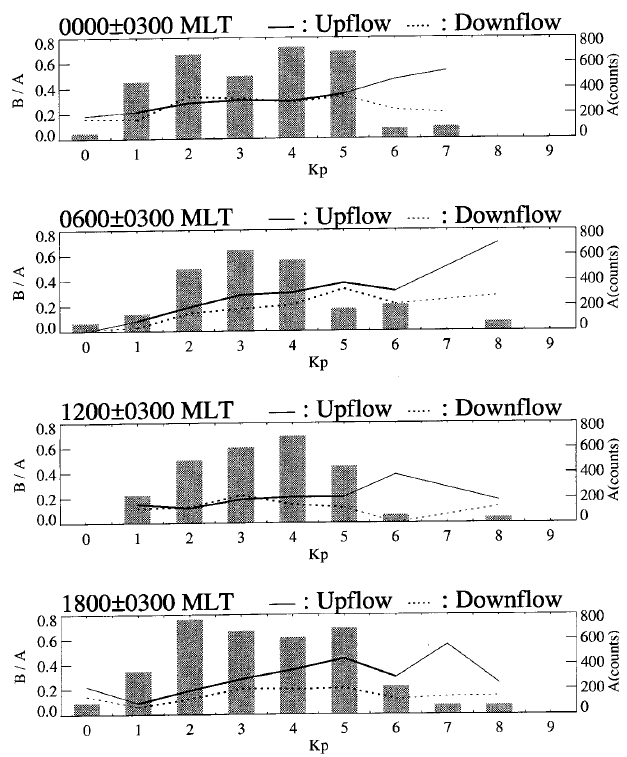
Fig. 7. The K dependence of the ion upflow and downflow in the P four MLT regions as in Fig. 5; dawn, midday, dusk and midnight regions